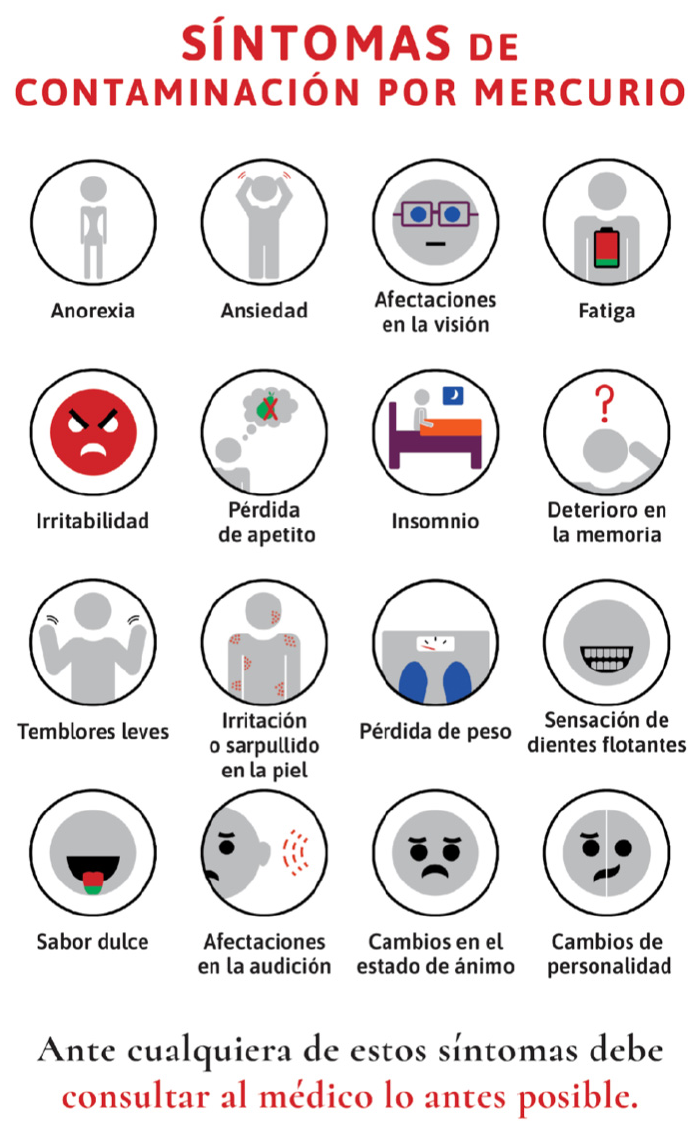
Figure 2. Public health infographics designed based on the findings of this study to communicate body systems affected by mercury vapor exposure. Infographic created by Maria Carolina Cuestas Moncada, Juan David Reyes Estupiñan, and David Felipe Salazar Chiguasuque and reproduced with permission.